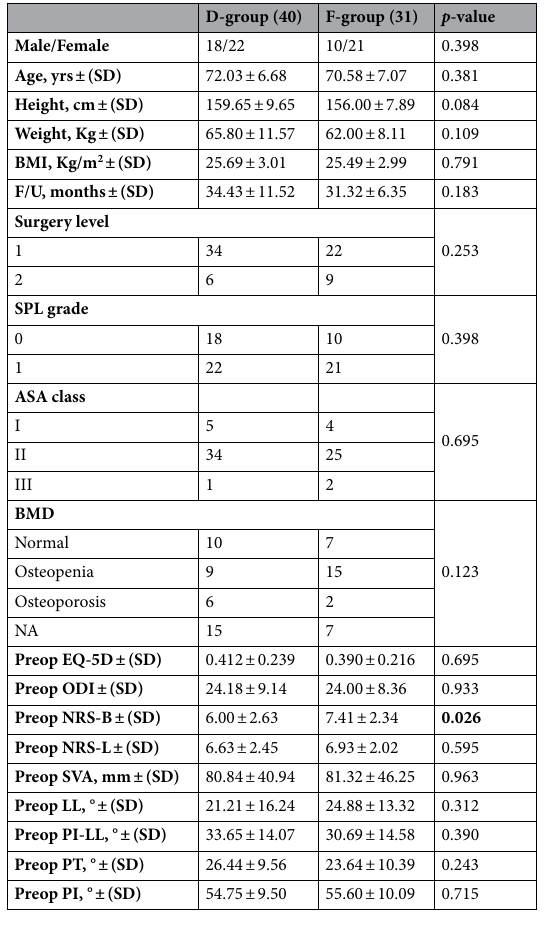
Table 1. Baseline characteristics. SD standard deviation, SPL spondylolisthesis, ASA class american society of anesthesiologists classification, BMD bone mineral density, NA not applicable, Preop preoperative, EQ- 5D euro-quality of life-5 dimensions, ODI oswestry disability index, NRS-B numerical rating score of pain on back, NRS-L numerical rating score of pain on leg, SVA sagittal vertical axis, LL lumbar lordosis, PI-LL difference between pelvic incidence and lumbar lordosis, PT pelvic tilt, PI pelvic incidence. Boldface type indicates statistical